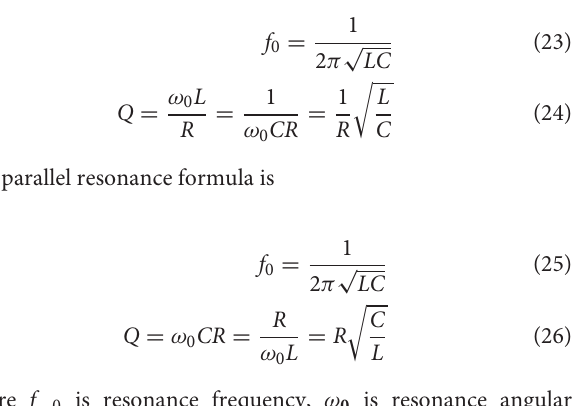
The field E z ( x,y ) radiated from the localized line source (14) is obtained by plugging Formula (25) into Formula (15).